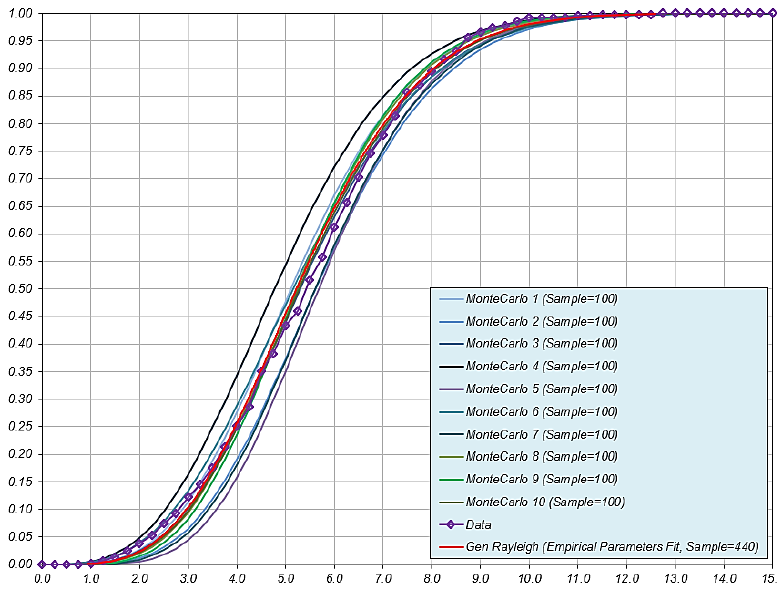
Figure A3. CDF simulated using subsets of sample with Size = 100.